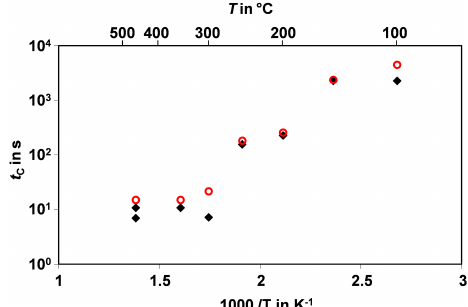
Figure 10. Characteristic time ( t c ) at different temperatures. The black squares symbolize the characteristic time from the conduc- tivity curves at the beginning of sulfur poisoning. The open circles denote the characteristic time from derived from the phase curves ( φ =− 45 ◦